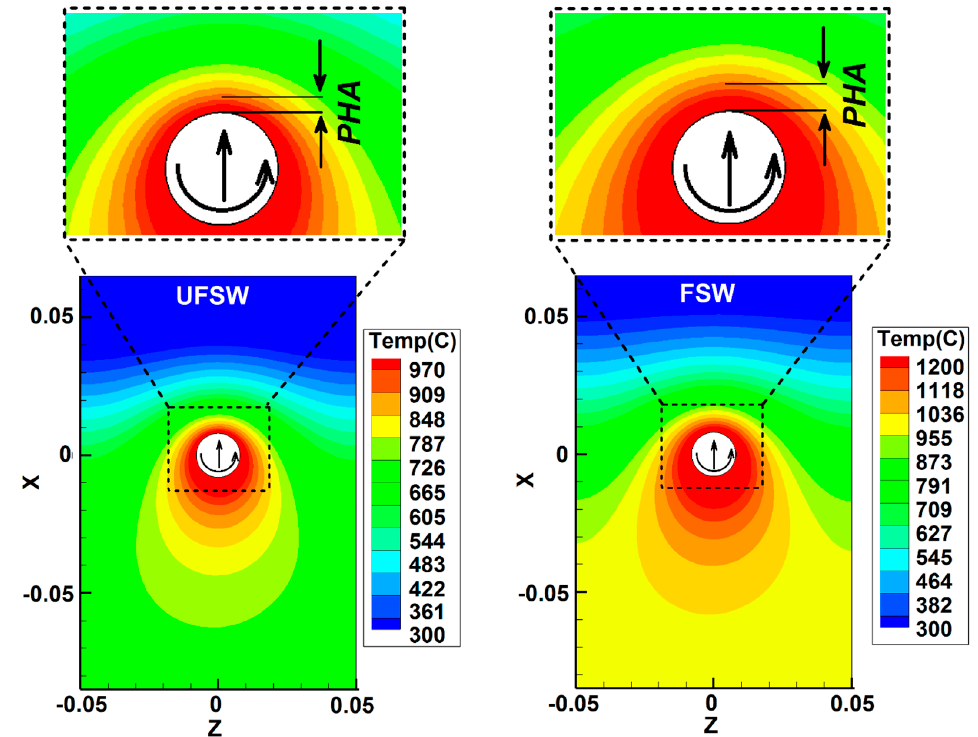
Figure 4. Simulation results of internal heat flow at FSW and UFSW cases.